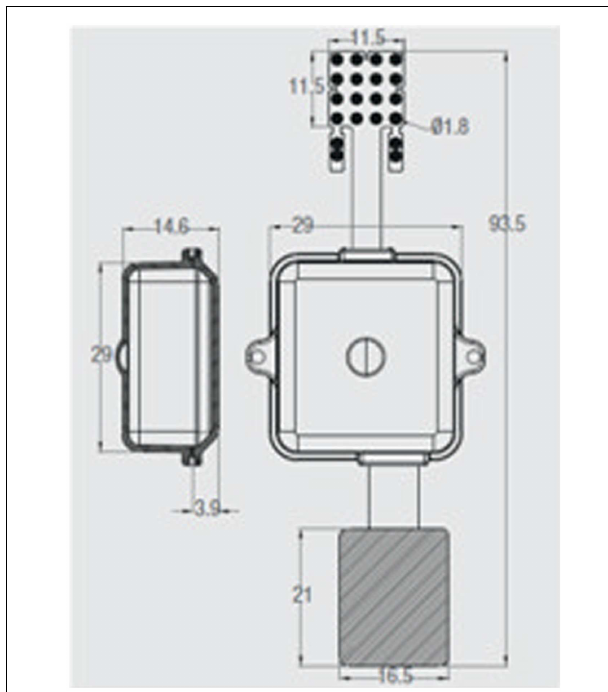
FIGURE 1 | System overview a fully implantable wireless system ECOGIW-16E .The 16-electrodes grid, the PEEK body (lateral and axial views) and the RF antenna are visible.